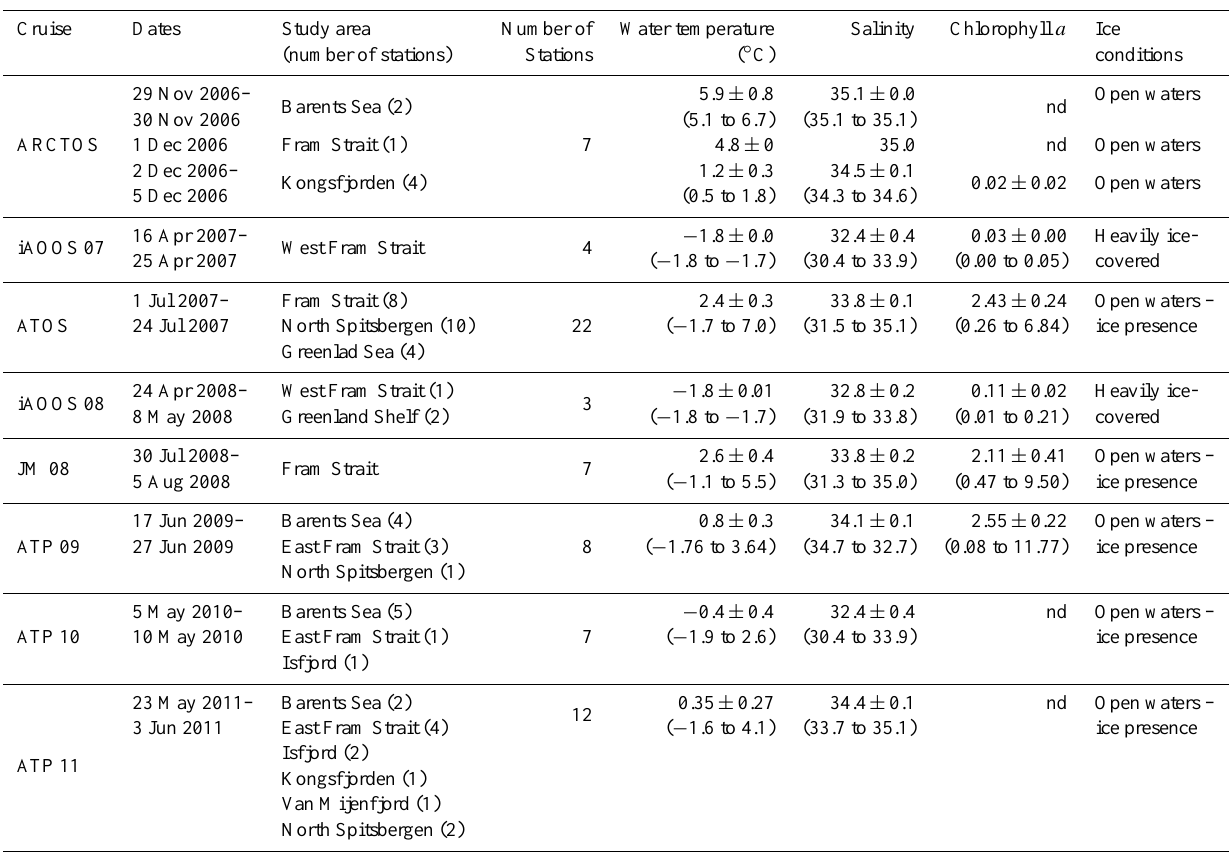
Table 1. Summary of water temperature ( ◦ C), Salinity and chlorophyll a content average ( ± SE, derived from the variance of the values used to calculate the mean) and range, and the corresponding ice conditions for the different cruises and different sampled areas (and number of stations sampled at each area) for the depths where metabolism was